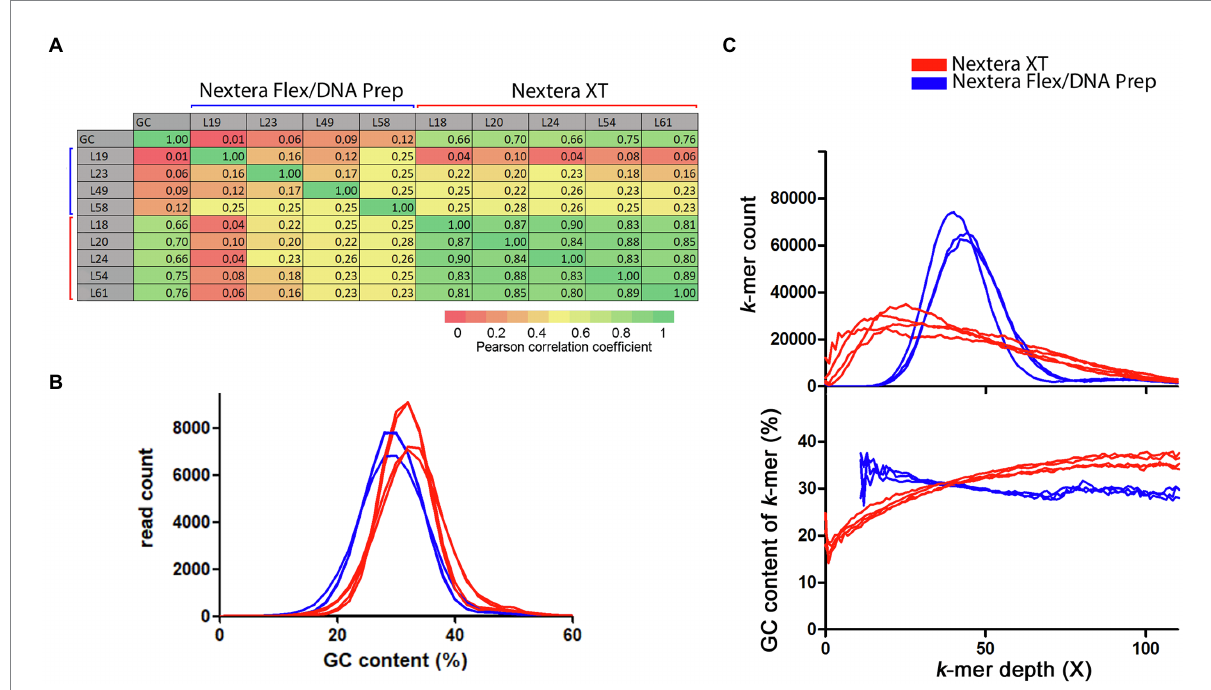
FIGURE 3 Connection between GC-content and coverage bias for the Campylobacter jejuni PT 28 dataset. The data have been colored to indicate the type of library prep kit used (Nextera XT red, Nextera Flex/DNA Prep blue). (A) Pearson’s correlation coefficients calculated between the sliding window coverage data and GC-content data. (B) Histogram over the GC-contents of the sequence reads. (C) Histogram over the depth of the reference sequence k -mers in the raw data downsampled to 50X (upper part) and the corresponding average GC-content of the k -mers in each histogram